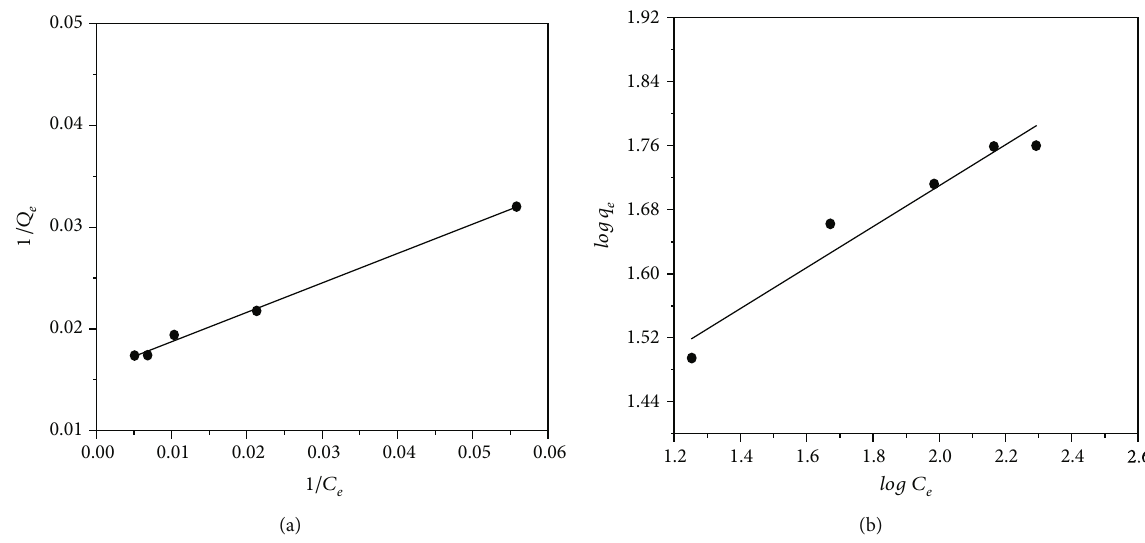
Figure 8: Adsorption isotherm models: (a) Langmuir and (b) Freundlich. Table 1: Isotherm parameters for methylene blue adsorption onto the prepared CPCN composite fi